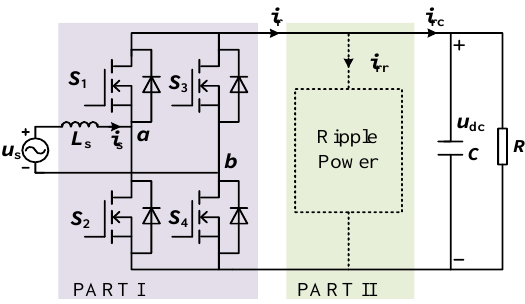
Figure 1. Topology of single-phase VSR with a power decoupling circuit.